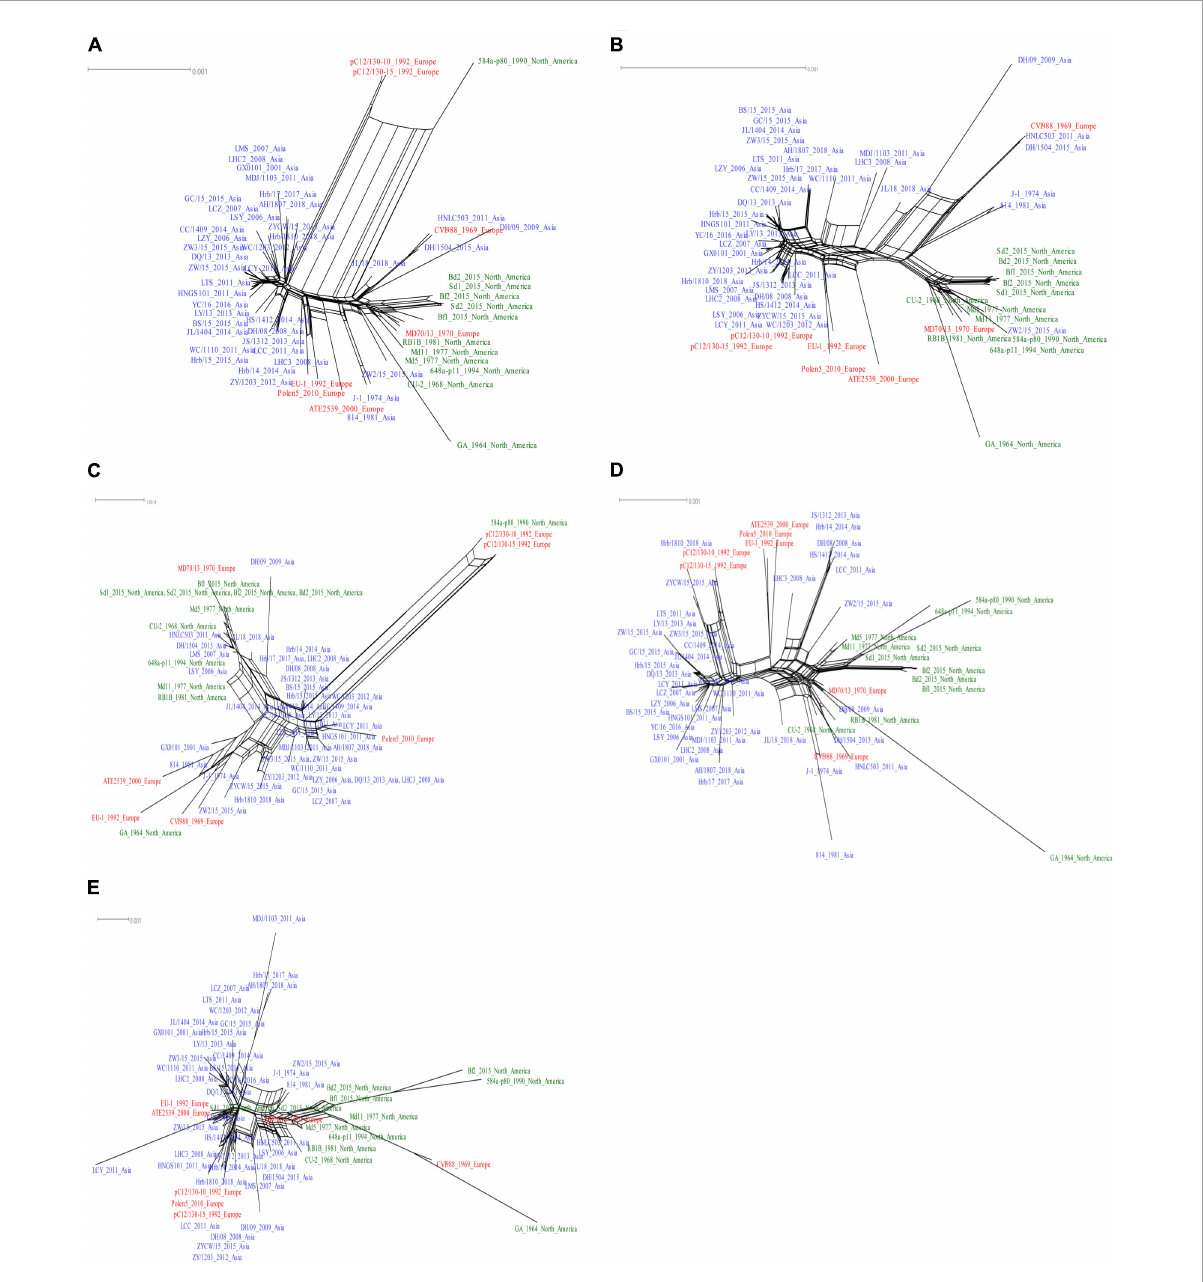
FIGURE5 Recombination network analyses of Marek’s disease virus (MDV) strains. Results are shown based on complete genome (A) , unique long (UL) (B) , unique short (US) (C) , internal repeat long (IRL) (D) , and internal repeat short (IRS) (E)